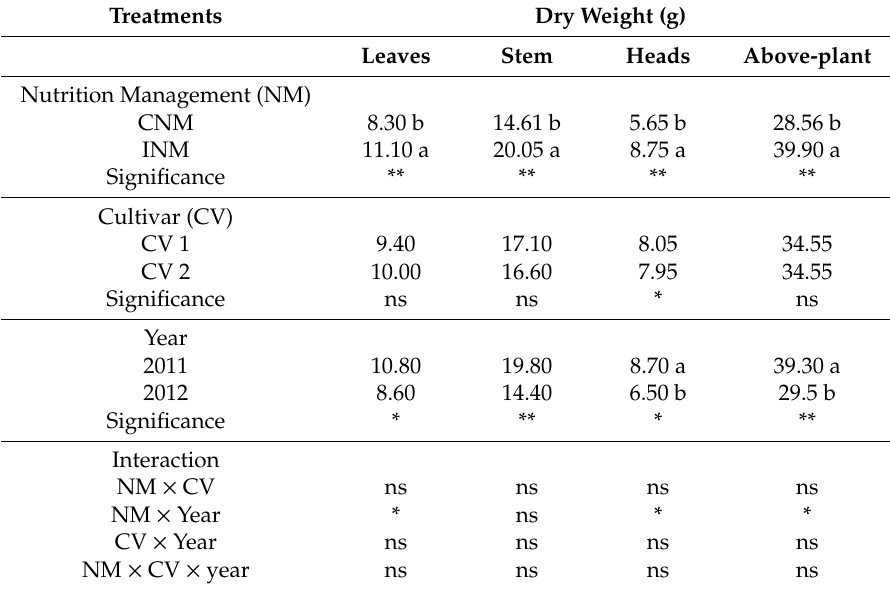
Table 4. Main e ff ects of nutrient management, cultivar on dry weight of various organs, and above-plant on chrysanthemum over the two years of application at harvest